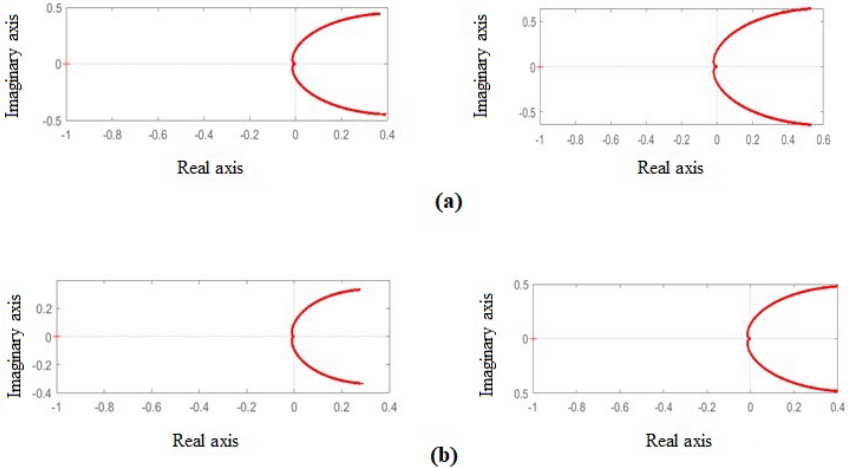
Figure 24. (a) Stability Analysis using Nyquist Plot for T in and H in using PID Controller and (b) Stability Analysis using Nyquist Plot for T in and H in using Fuzzy Based PID Controller.